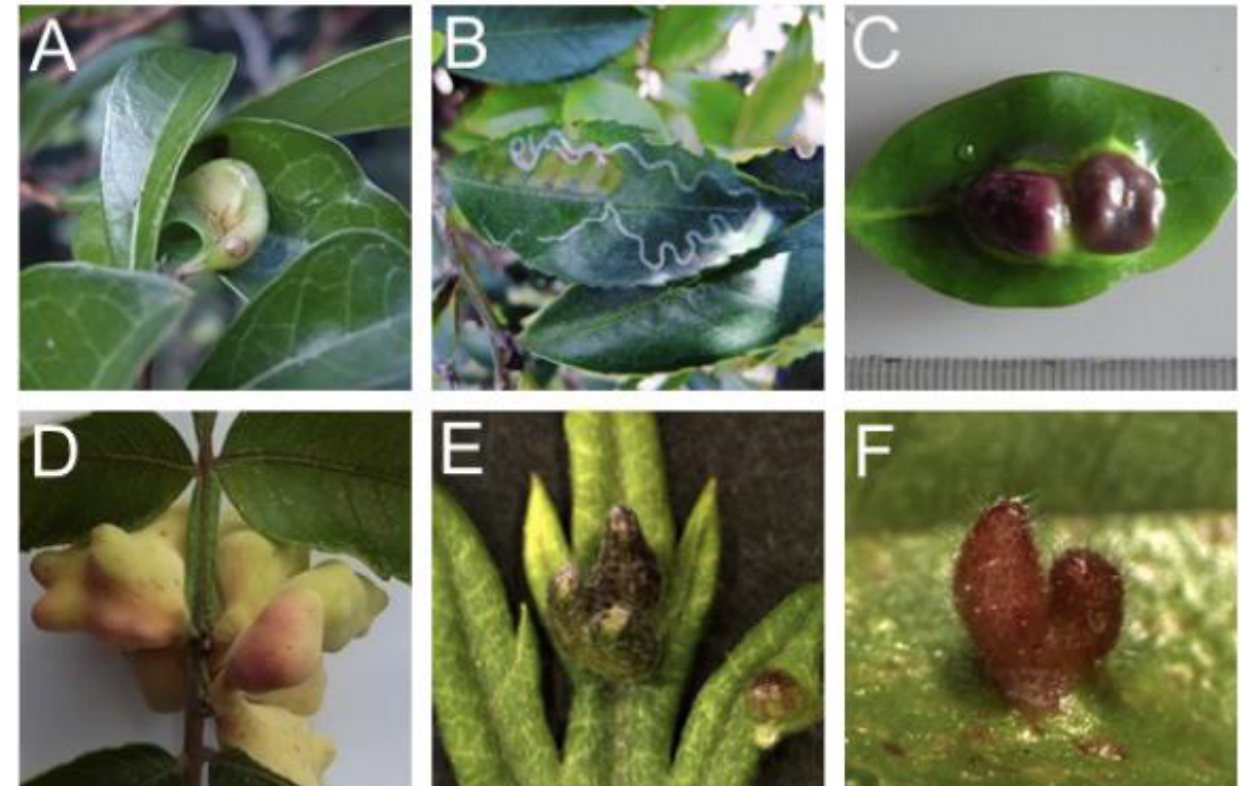
Figure 1. Examples of insect galls generated on leaves. ( A ) Glochidion obovatum gall by the micromoth Caloptilia cecidophora . ( B ) Eurya japonica gall by the micromoth Borboryctis euryae . ( C ) Distylium racemosum gall by the aphid Neothoracaphis yanonis . ( D ) Rhus javanica gall by the aphid Schlechtendalia chinensis . ( E ) Artemisia montana gall by the gall midge Rhopalomyia yomogicola . ( F ) Ulmus parvifolia gall by Tetraneura akinire . Panels ( A , D ) are from a previous study [7].